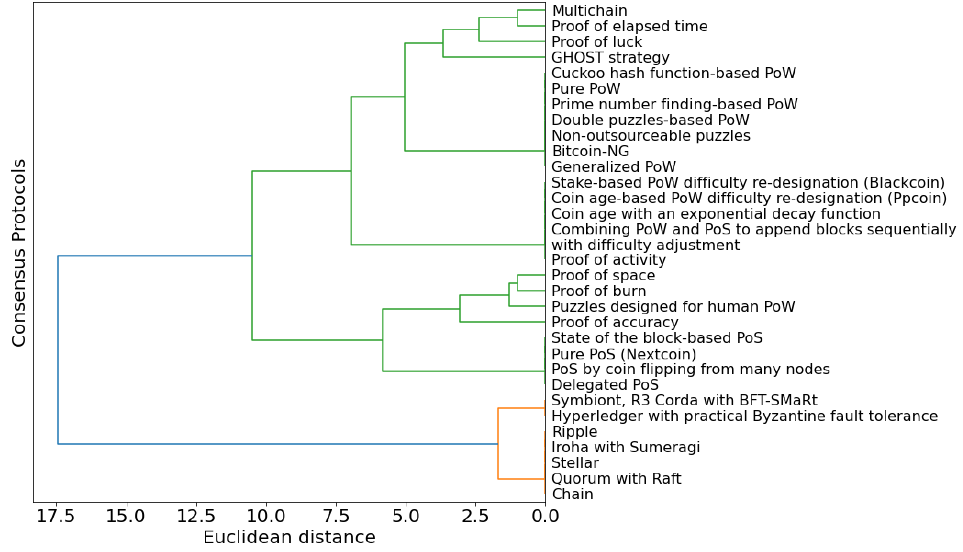
Figure 7. Hierarchical clustering